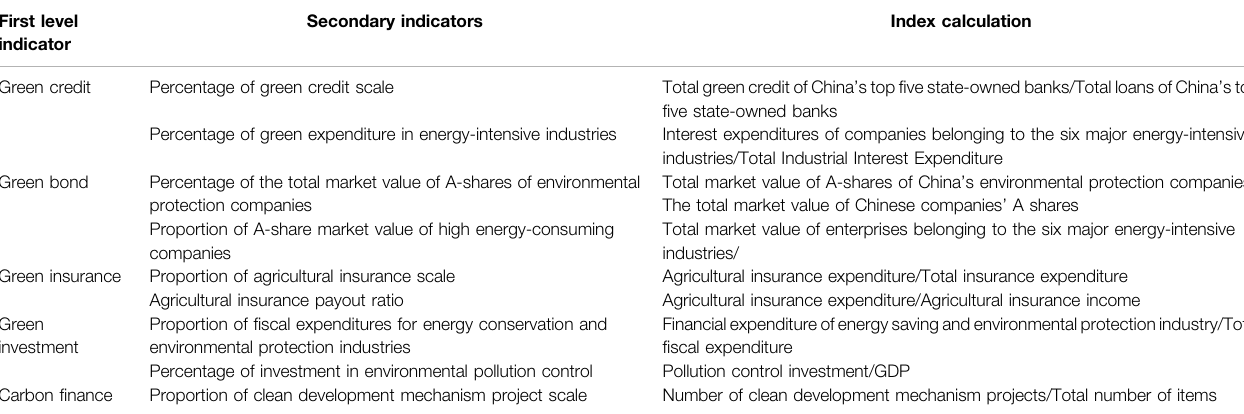
TABLE 2 | Green fi nance index system.